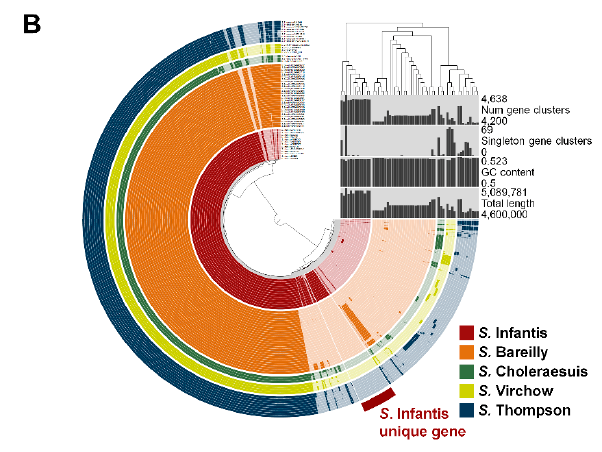
Figure 1. Pangenome distribution of ( A ) 568 Salmonella strains of 60 serovars and ( B ) 56 strains of five serovars, namely S . Infantis, S . Bareilly, S . Choleraesuis, S . Virchow, and S . Thompson. Each arc represents a genome, and each layer displays the pangenome distribution. Black arcs in ( A ) represent the genomes of 555 Salmonella strains not belonging to S . Infantis. The dark and bright regions of each arc indicate core genome presence and absence, respectively. The red, orange, green, yellow, and blue arcs in ( B ) denote the genomes of S . Infantis, S . Bareilly, S . Choleraesuis, S . Virchow, and S. Thompson, respectively.